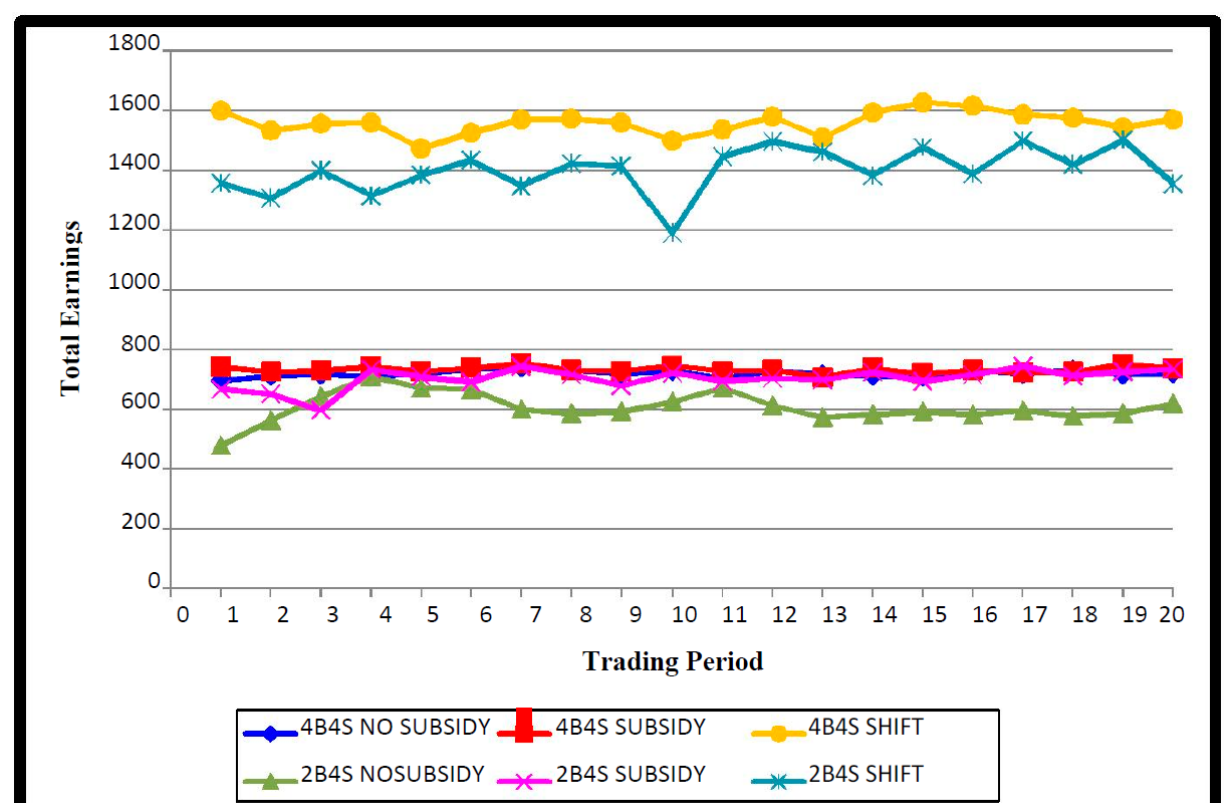
Figure 6. Average total earnings per trading period by treatment.